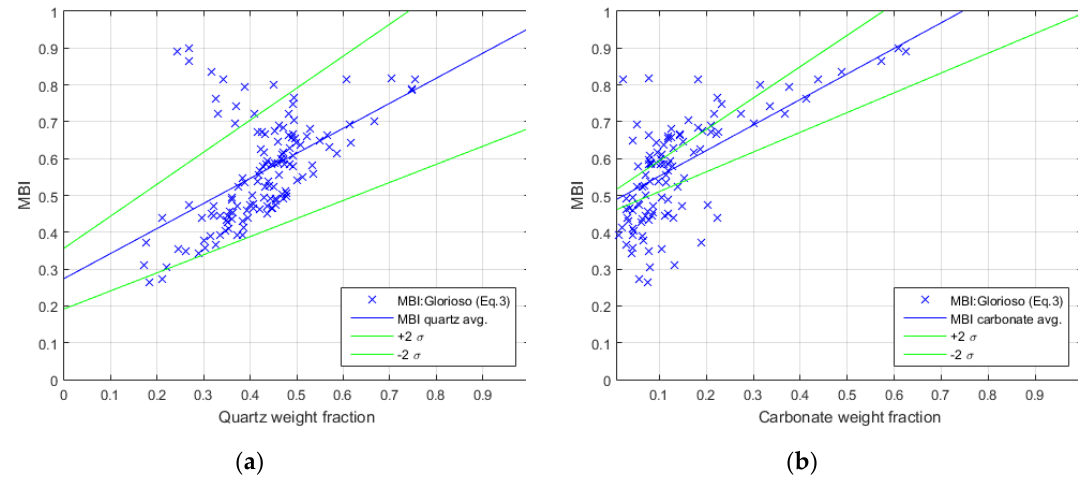
Figure 3. Comparison between the MBI derived using the Glorioso and Rattia [16] correlation and the mineral weight fraction applied on the Marcellus Formation. ( a ) Comparison with a quartz weight fraction. ( b ) Comparison with a carbonate (calcite and dolomite) weight fraction.